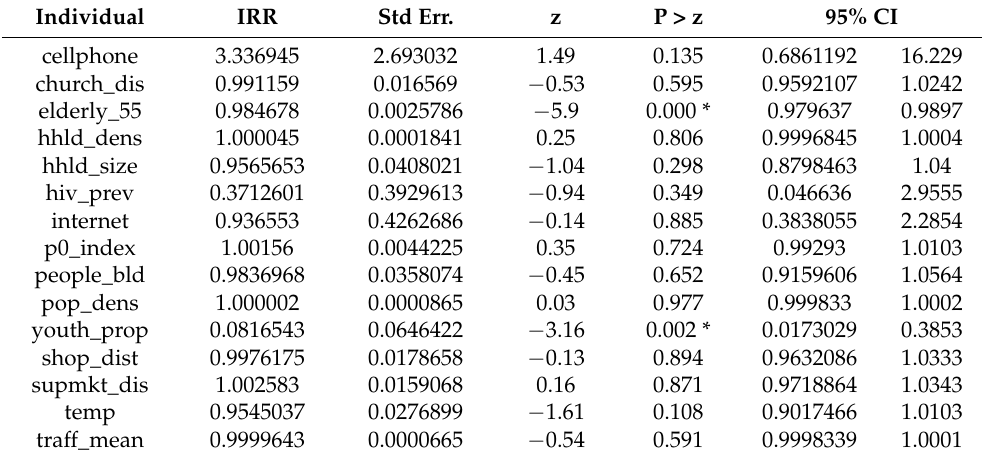
Table 2. Results of the Poisson model.